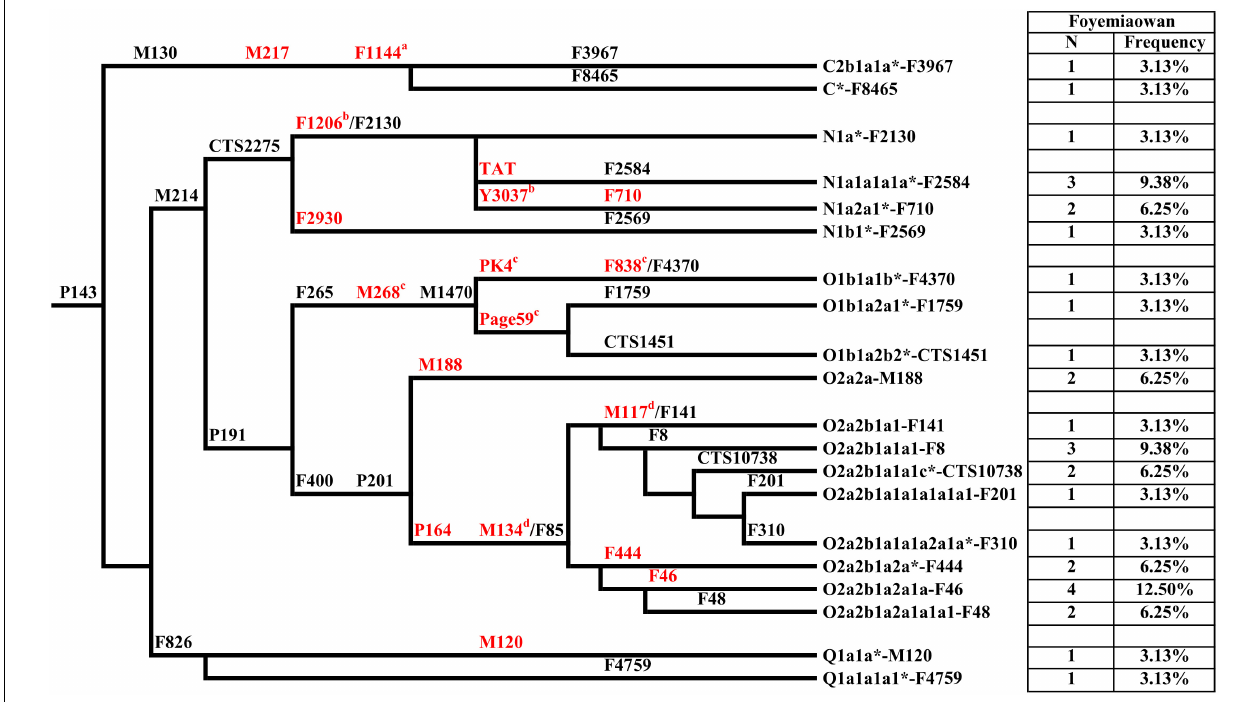
Frontiers in Ecology and Evolution |